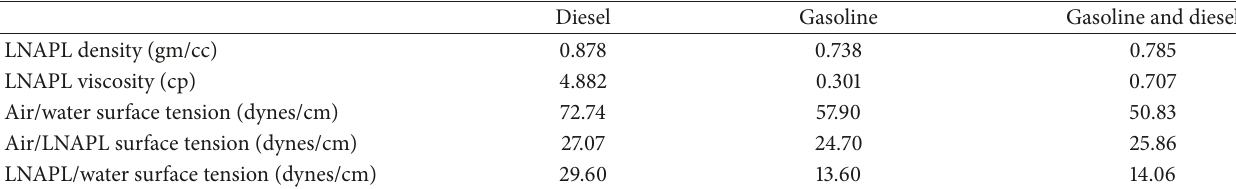
Table 1: LNAPL input parameters in LDRM for specific volume estimation.